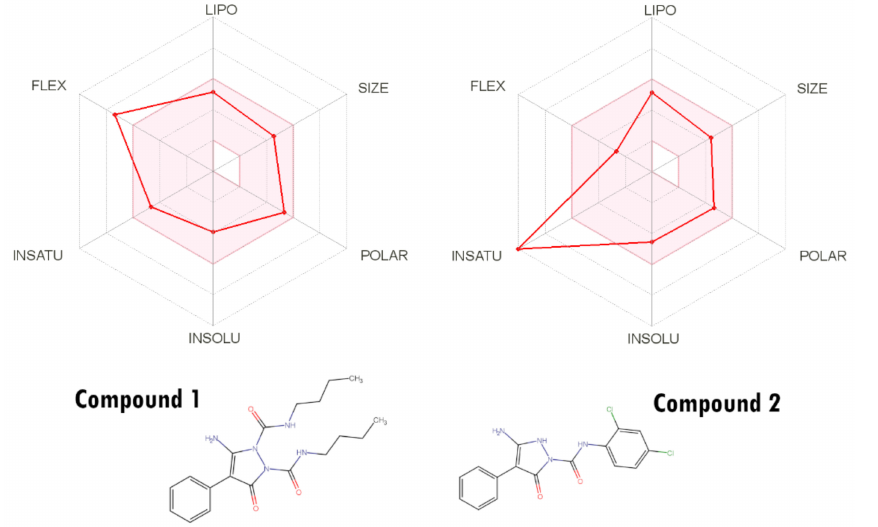
Figure 8. Oral bio-availability graph generated using the SwissADME service. The red–coloured zone is physicochemically suitable for oral bio-availability. LIPO—lipophility ( − 0.7 < XlogP3 < +5.0); SIZE—molecular weight (150 g/mol < MW < 500 g/mol); POLAR—polarity (20 Å 2 < TPSA < 130 Å 2 ); INSOLU—insolubility (0 < logS < 6); INSATU—insaturation (0.25 < fraction Csp3 < 1); FLEX—flexibility (0 < num. of rotatable bonds <